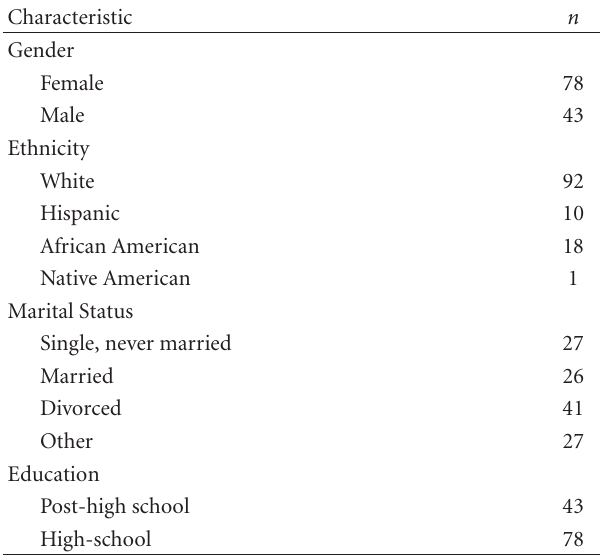
Table 1: Participant demographic